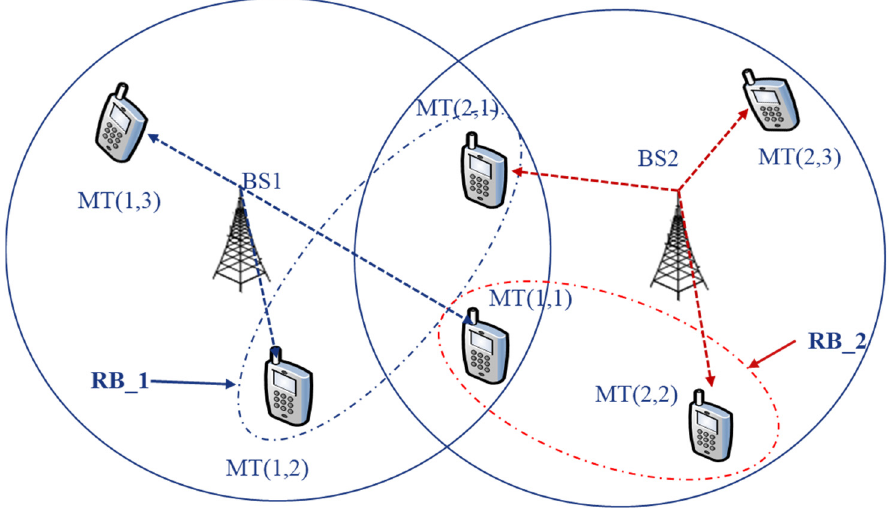
Figure 11. An illustration of downlink resource allocation for a multi-service